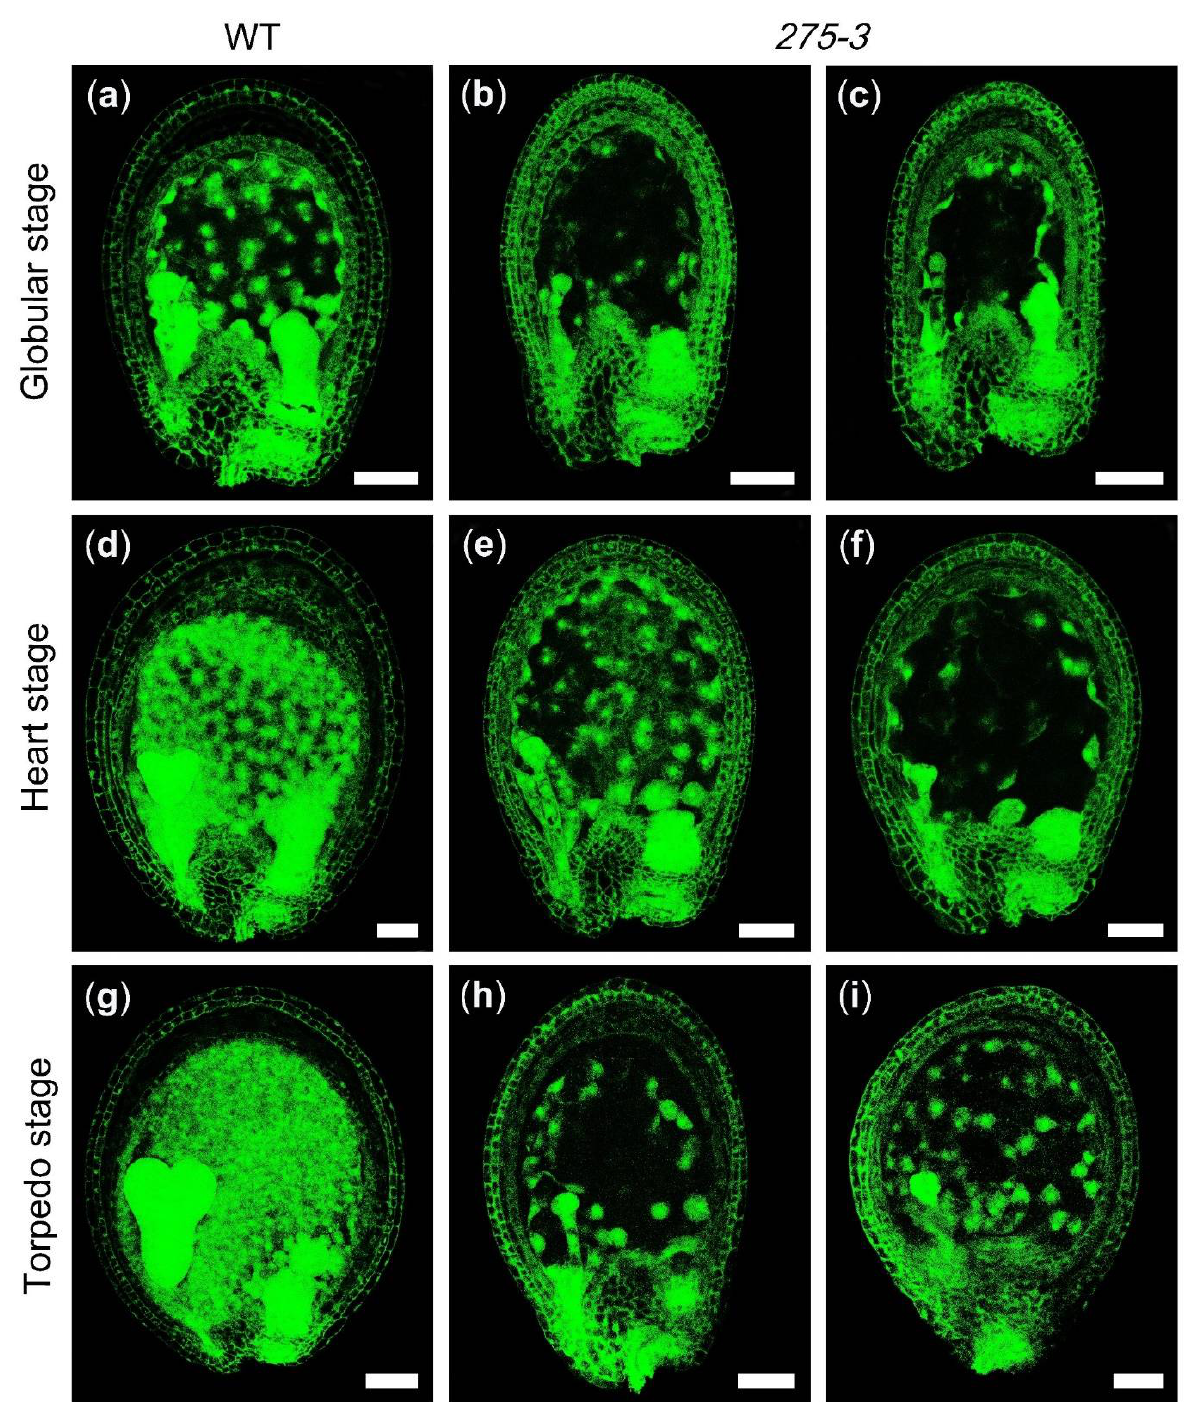
Figure 3. The developmental process of endosperm in Arabidopsis mutant 275-3 . ( a , d , g ) WT ovules. ( b , c , e , f , h , i ) The ovules in the mutant 275-3 . Scale bars = 50 μm.